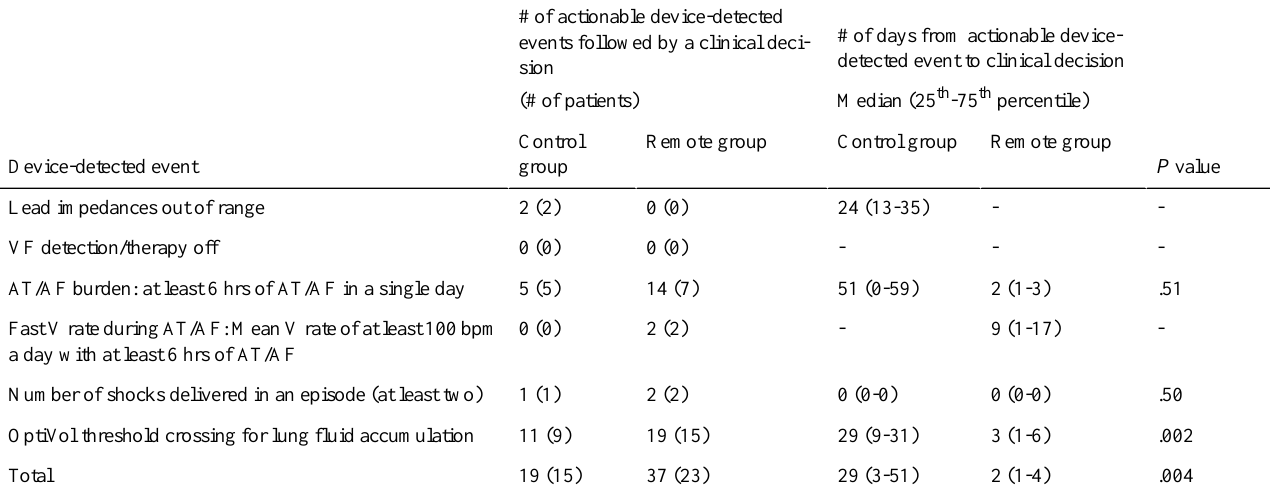
Table 3. Delay in clinical decisions—delays from a device-detected event to a clinical decision.